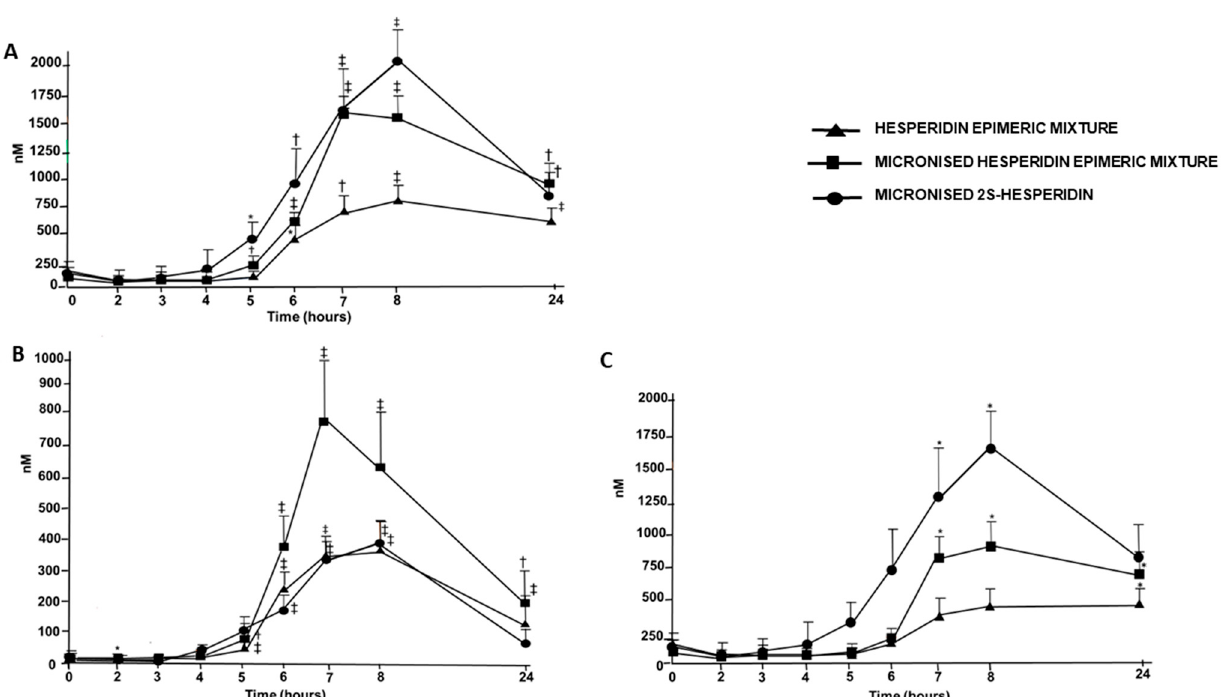
Figure 3. Time–response curve of the sum of serum hesperidin metabolites and catabolites ( A ), serum hesperidin metabolites ( B ) and serum hesperidin catabolites ( C ), after Hesperidin epimeric mixture (HEM), micronized Hesperidin epimeric mixture (MHEM) and micronized 2S-Hesperidin (M2SH) treatments. * p < 0.05, † p < 0.01, ‡ p < 0.001 versus baseline.